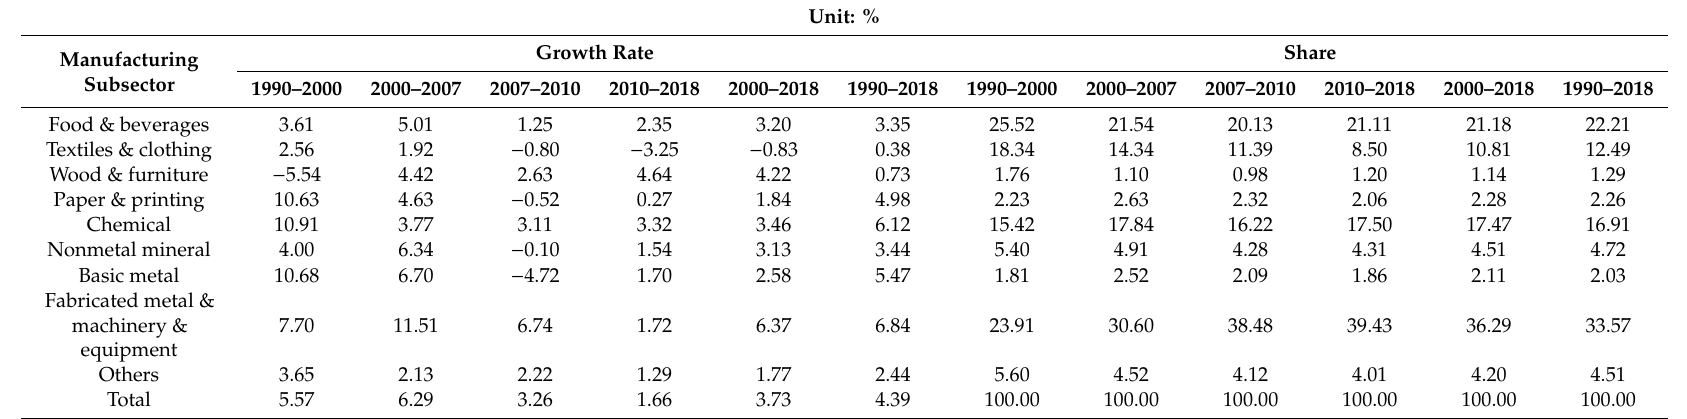
Table 3. Average annual growth rate and percentage share of subsectoral manufacturing production, 1990–2018. Unit: